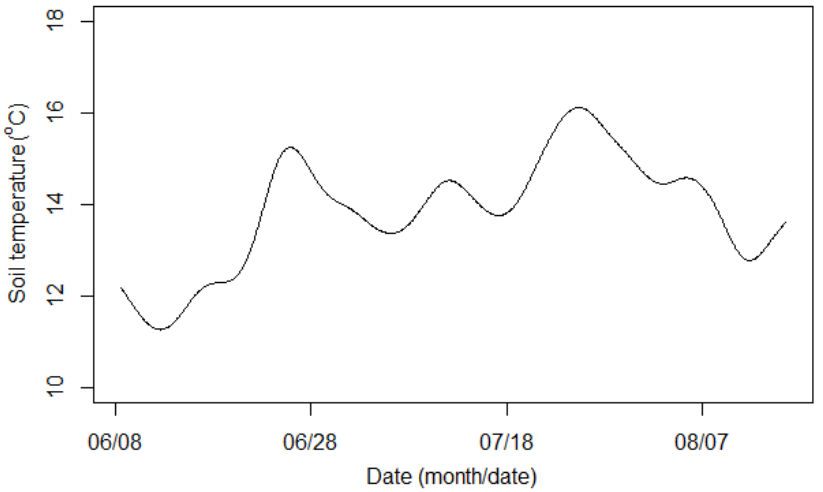
Figure 8. Soil temperature measured at 5 cm depth throughout the measurement period. The soil temperature probe was placed close to the chamber plots, with all plots being within a distance of 10 m. A rolling average has been applied to the raw soil temperature measurements.